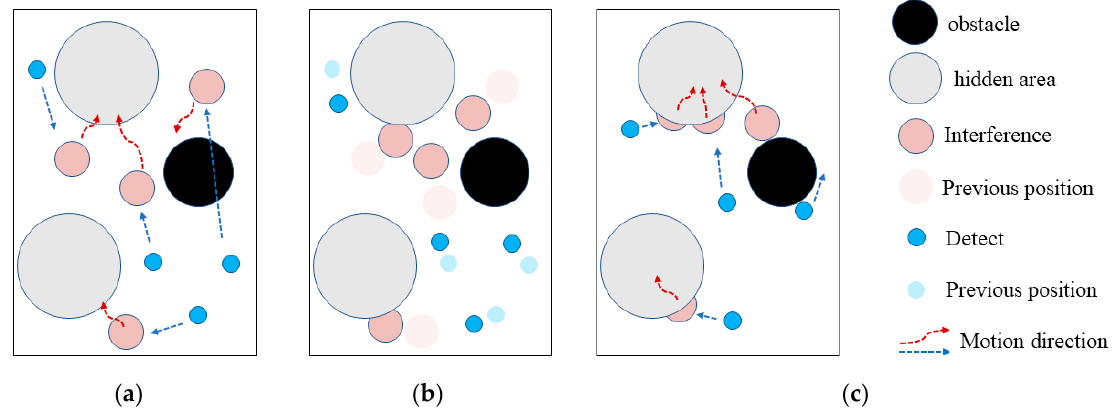
Figure 12. Diagram of the confrontation process in the multi-agent obstacle-covert confrontation environment: ( a ) detection agents’ action, ( b ) interference agents’ action, and ( c ) action process of the detection agent and the interference agent .